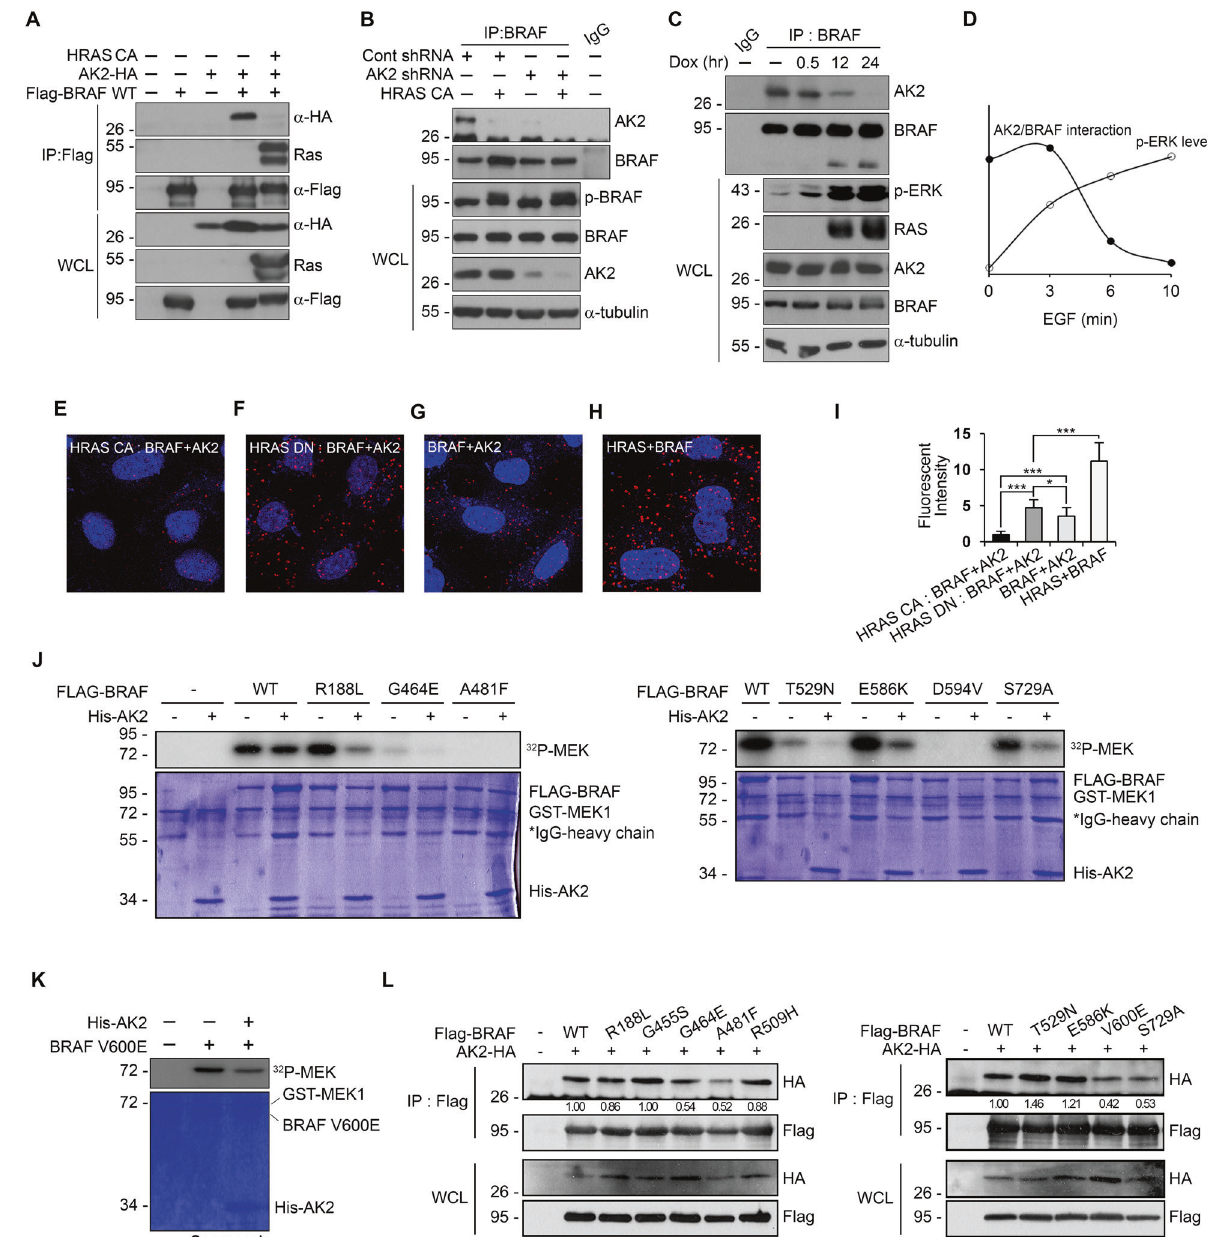
Fig. 6 RAS activation impairs the AK2-BRAF interaction and AK2 restrains inhibitor-insensitive BRAF mutants. A – C RAS activation reduces the association of AK2 and BRAF. HEK293T cells were cotransfected with Flag-BRAF, AK2-HA, and either control vector (-) or constitutively active HRAS (HRAS CA) for 24 h and then subjected to immunoprecipitation (IP) analysis ( A ). Hep3B and Hep3B-shAK2 cells were transfected with activated HRAS (HRAS CA) and then subjected to immunoprecipitation (IP) analysis ( B ). NIH3T3 cells stably expressing HRAS V12 were treated with 0.5 μ g ml − 1 doxycycline for the indicated times and subjected to immunoprecipitation (IP) analysis ( C ). Total ɑ -tubulin was used as a loading control. D A graph showing the relative association between AK2 and BRAF in HeLa cells upon EGF (50 ng ml − 1 ) treatment over the indicated period of time. E – I In situ proximity ligation assay showing the regulated interaction between AK2 and BRAF according to HRAS activity. HeLa cells were left untreated ( G , H ) or transfected with either HRAS-CA ( E ) or HRAS-DN ( F ), and then subjected to PLA and DAPI staining for visualization of nuclei (blue). Red dots indicate the protein – protein interaction between RAS and BRAF ( H ) and BRAF and AK2 ( E – G ). The intensities of red dots in the assays were quanti fi ed ( I ) ( n = 7; different fi elds of microscopy; values are presented as mean ± SD ( n = 3; * p < 0.05, ** p < 0.01, *** p < 0.001). J AK2 reduces the kinase activity of BRAF mutants found in cancer patients. HEK293T cells were transfected with Flag-BRAF (WT) or cancer patient-found BRAF mutants. Flag-BRAF proteins were then immunopuri fi ed and assayed for the kinase activity using γ - 32 p-MEK1 in the absence or presence of His-AK2 protein. K In vitro modulation of BRAF V600E activities by AK2. Puri fi ed AK2 protein (1 μ M) was incubated with BRAF V600E protein (10 nM). MEK phosphorylation was visualized by autoradiography. Proteins utilized in the assay were con fi rmed by western blotting and Coomassie staining. L Interaction of AK2-BRAF mutants. HEK293T cells were transfected with AK2-HA and Flag-tagged BRAF mutants for 24 h and subjected to immunoprecipitation (IP) assays using Flag antibody. The immunoprecipitates and whole cell lysates (WCL) were analyzed by western blotting. Ratio of [anti-HA; FLAG-IP] to [anti-HA; WCL] on each BRAF mutant are represented in the blots.